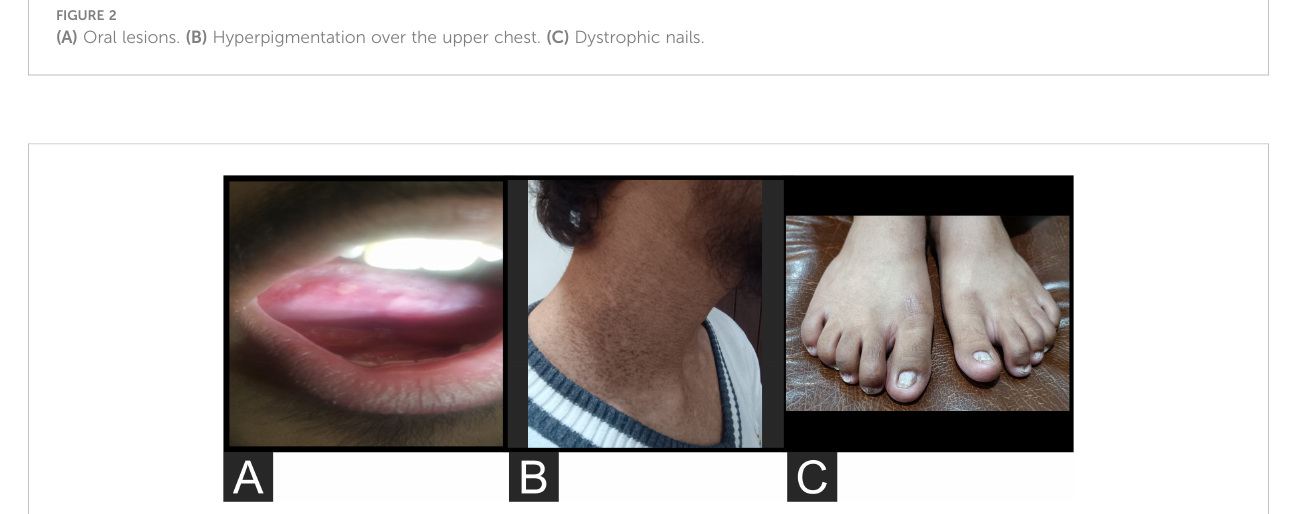
FIGURE 3 (A) Leukoplakia. (B) Reticulated hyperpigmentation over the side and front of the neck. (C) Dystrophic nails.